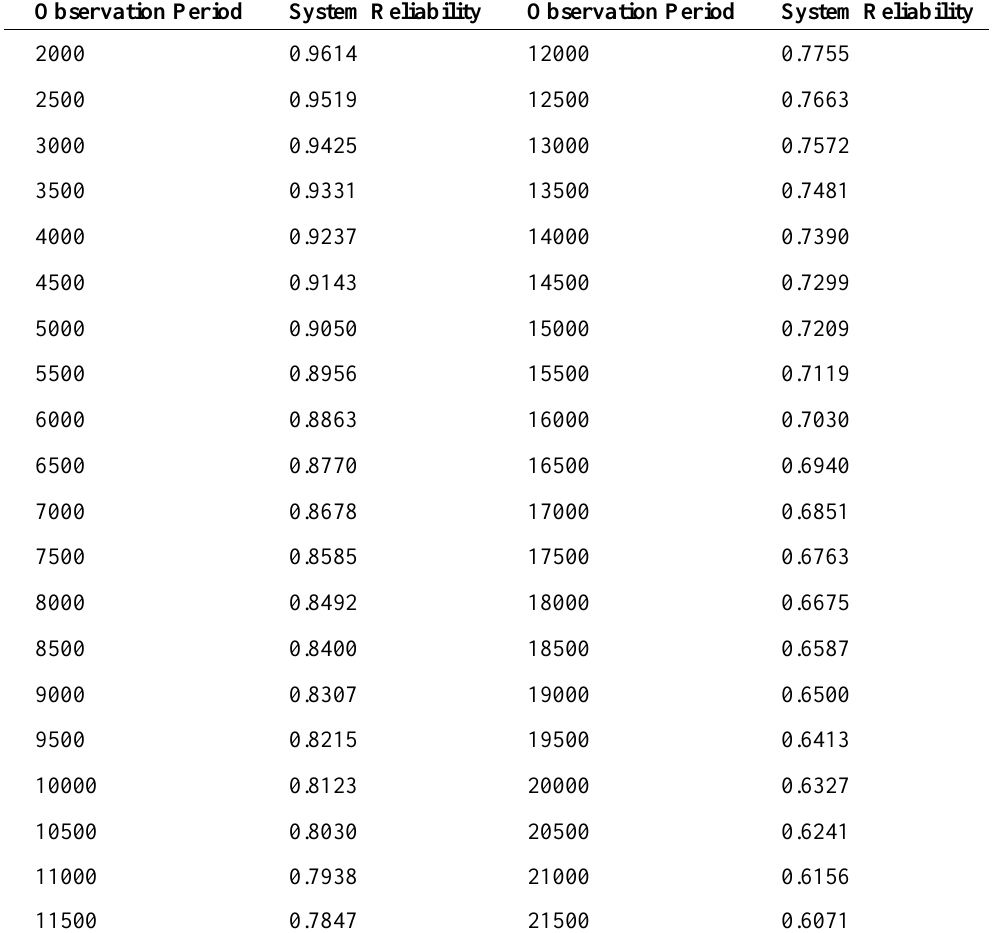
Table 4. Reliability of system for Example 1 in 40 different times with analytical